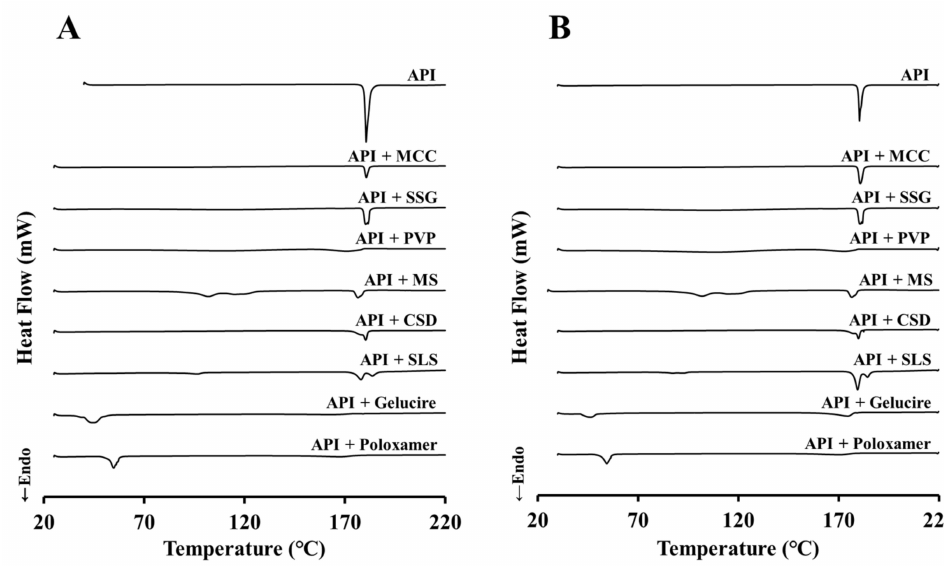
Figure 3. The results of compatibility studies via DSC. ( A ) Initial; ( B ) 4w, 40 ± 2 ◦ C/75 ± 5% RH. Table 4. The results of compatibility study by impurities analysis in